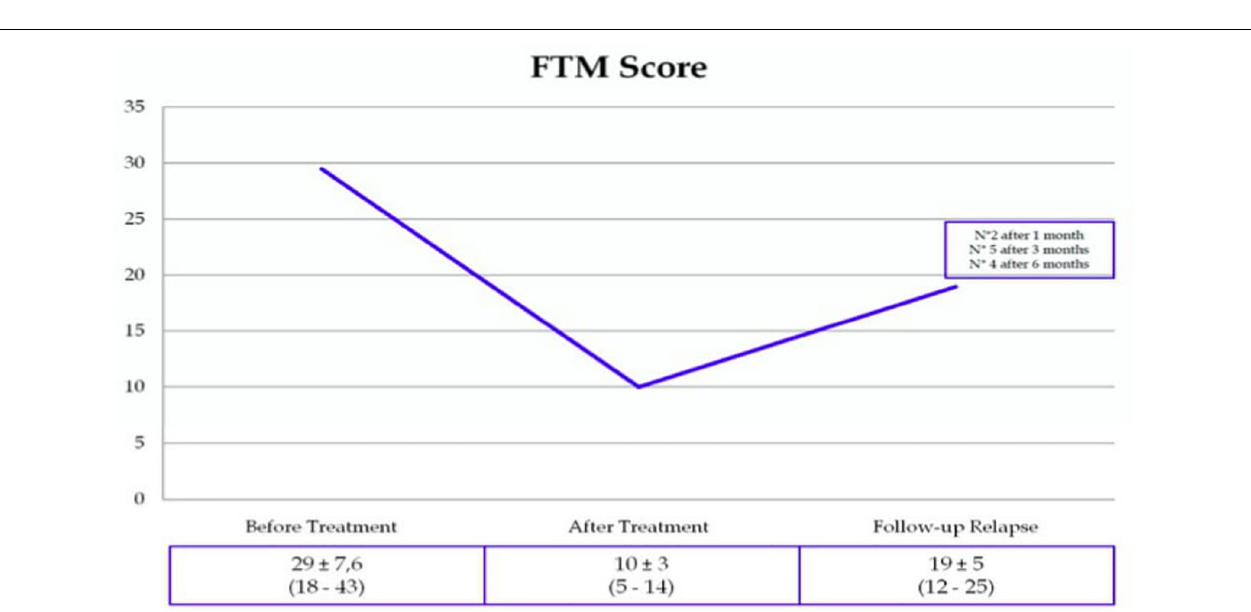
FIGURE 1 | Box plot of changes in scores at the Fahn-Tolosa-Marin (FTM) part A side treated (range 0–9) with 2-years follow up in patients with Parkinson tremor dominant unilateral and in patients with Essential tremor.